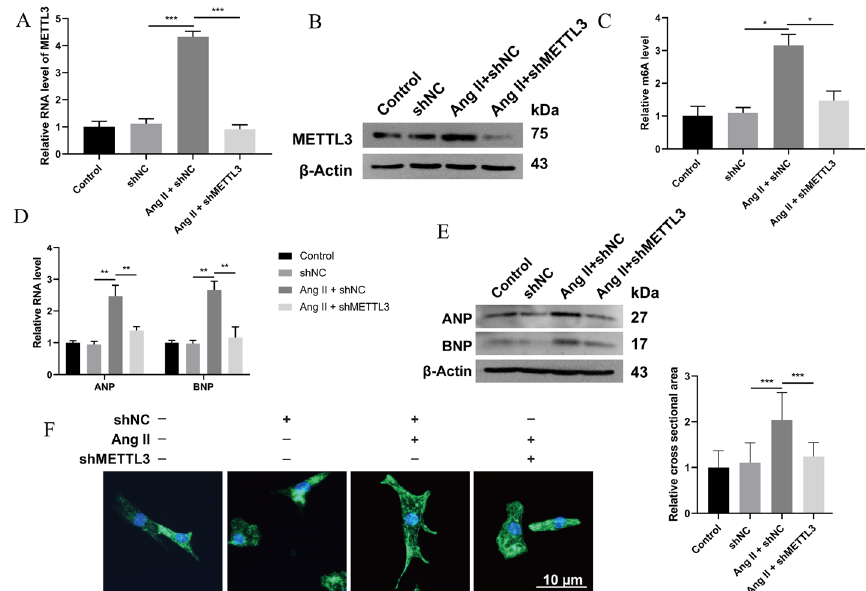
Fig. 2 Knockdown METTL3 expression inhibits Ang-II-induced cardiomyocyte hypertrophy. A qRT-PCR detected the expression of METTL3 in Ang-II-induced NRCMs transfected with shMETTL3. n blot detected the expression of METTL3 in Ang-II-induced NRCMs transfected with shMETTL3. n Assay detected m6A modification of total RNA in Ang-II-induced NRCMs transfected with shMETTL3. n D qRT-PCR detected the expression of biomarkers ANP and BNP in Ang-II-induced NRCMs transfected with shMETTL3. n 3. E Western blot detected the expression of biomarkers ANP and BNP in Ang-II-induced = NRCMs transfected with shMETTL3. n 3. F NRCMs were transfected with shMETTL3, followed by Ang-II = stimulation. Representative immunohistochemistry images of NRCMs stained with α-actinin in green. The nucleus is stained in blue. Scale bars represent 10 μm. The cell surface area was evaluated. n ** P < 0.01, *** P <